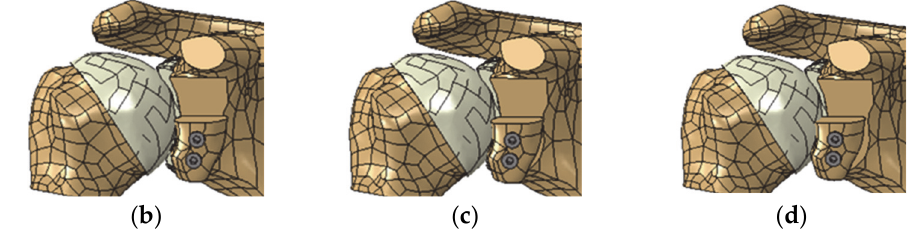
Figure 2. Anterior–posterior view of the medial–lateral positions considered for the bone graft in the Latarjet procedure: ( a ) ML ‐ 0 mm; ( b ) ML ‐ 1.5 mm; ( c ) ML ‐ 3.0 mm; and ( d ) ML ‐ 4.5 mm. Table 1. Evaluation of graft positions, in mm, according to the axial circle method. Positive distances mean the bone graft is lateralized, whereas negative distances mean the bone graft is medialized. Latarjet